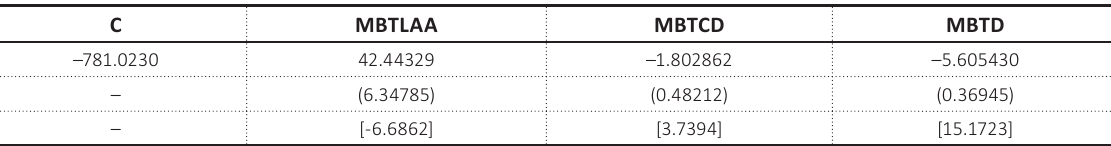
Source: Researcher’s